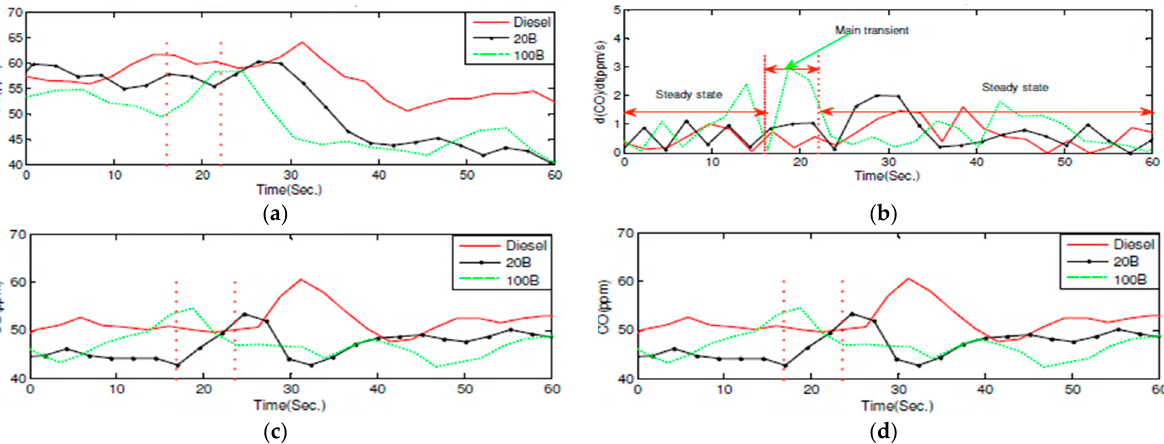
Figure 16. ( a ) Engine CO emission running with the three fuels during positive torque transient at 1500 rpm; ( b ) corresponding rate of change of CO emission at the same conditions. ( c ) Variation of CO emission of CI engines with time for running with different fuels during the negative torque transient of 420 to 210 Nm at 1500 rpm; ( d ) rate of change of CO emission under the same conditions.